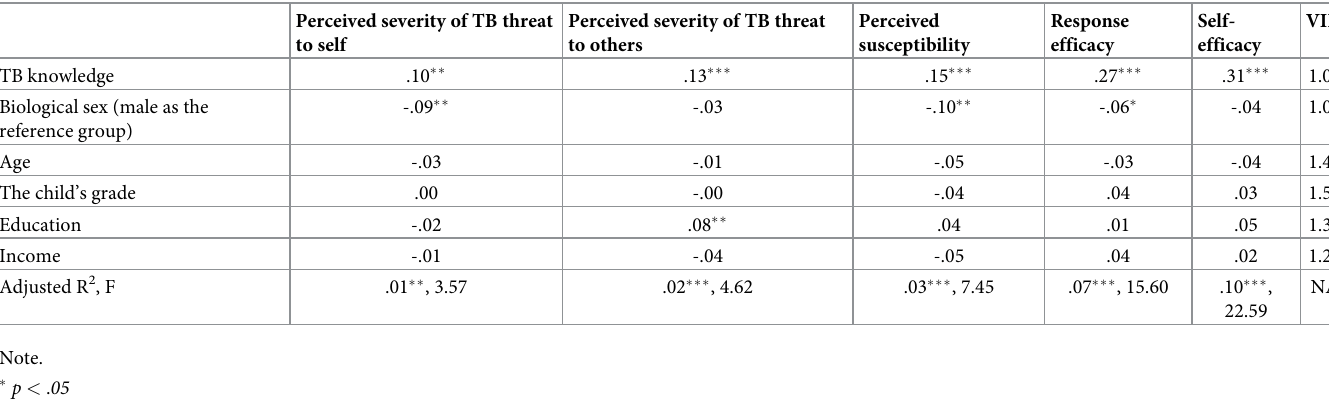
Table 1. The effect of TB knowledge on TB-related risk perception and efficacy appraisal.